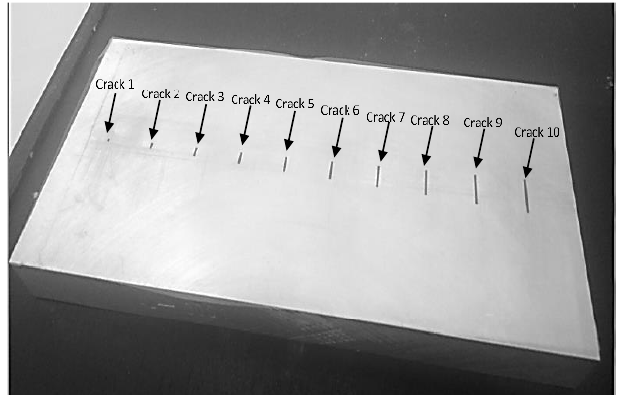
FIGURE 5. Aluminium plate using.